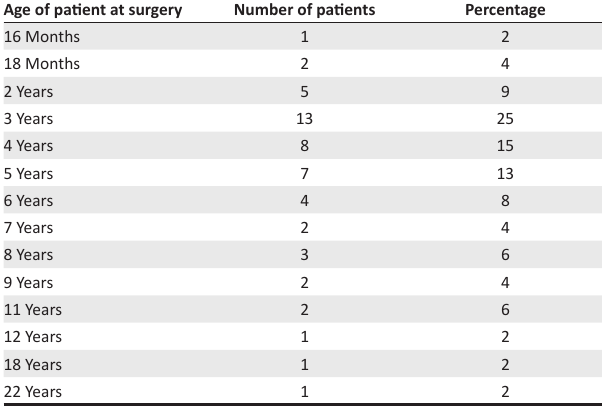
TABLE 2: Age distribution versus number and percentage for those patients with known demographic data.